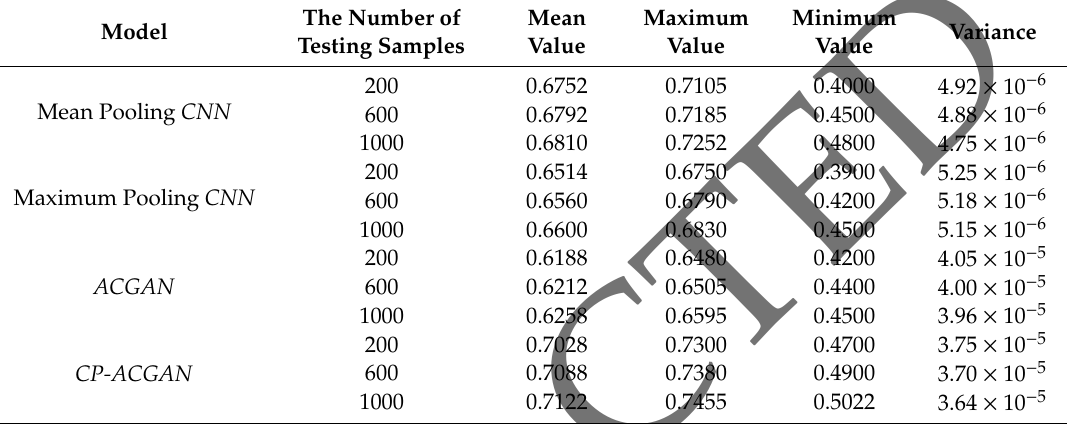
Table 4. CIFAR100 prediction accuracy. Mean value, maximum value, minimum value and variance of di ff erent methods in 1000